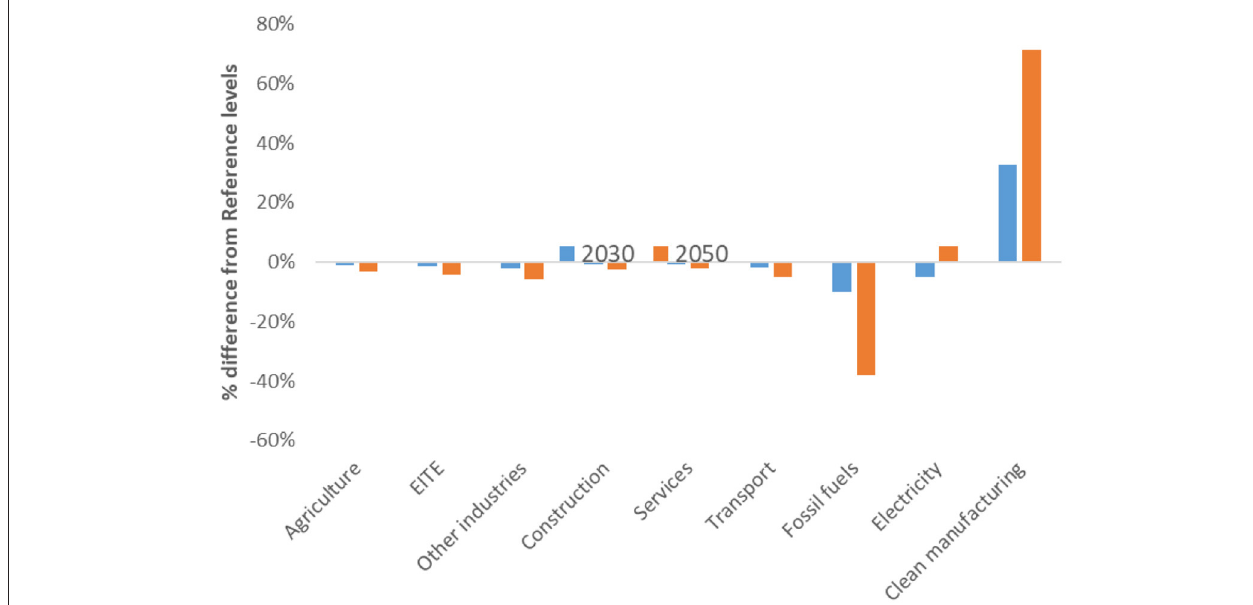
FIGURE 14 | Impacts of 2DEG scenario on global production by main sector.